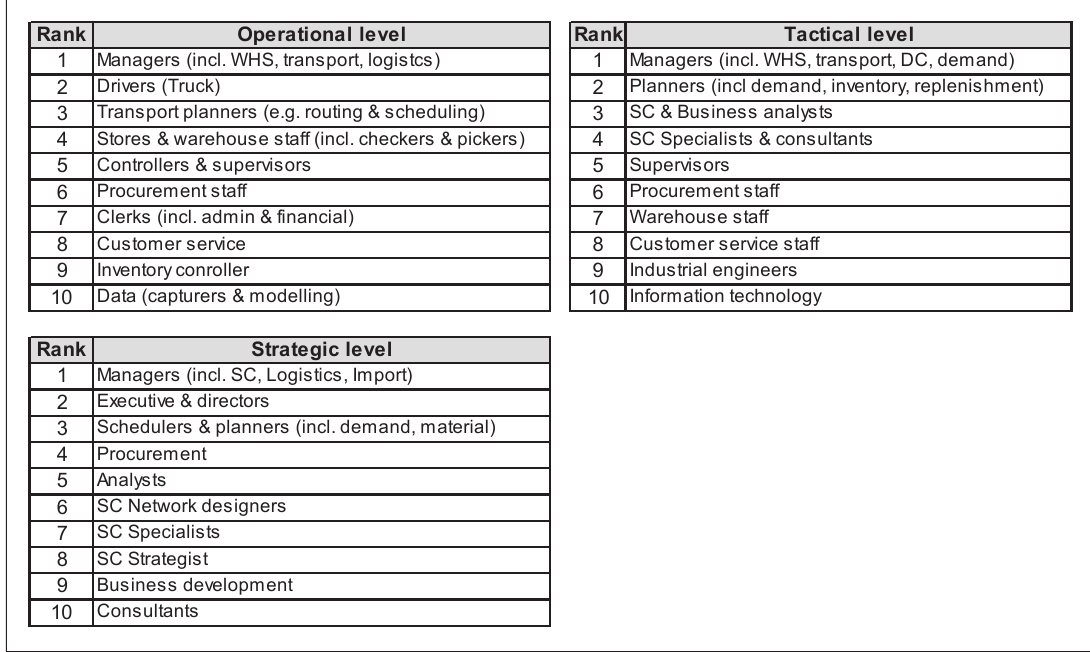
Table 5: List of job functions